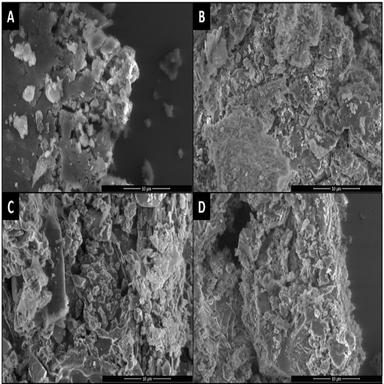
SEM analysis of bare g-C3N4 (a), Fe/g-C3N4 (b), Bi/g-C3N4 (c), Mn/g-C3N4 (d).